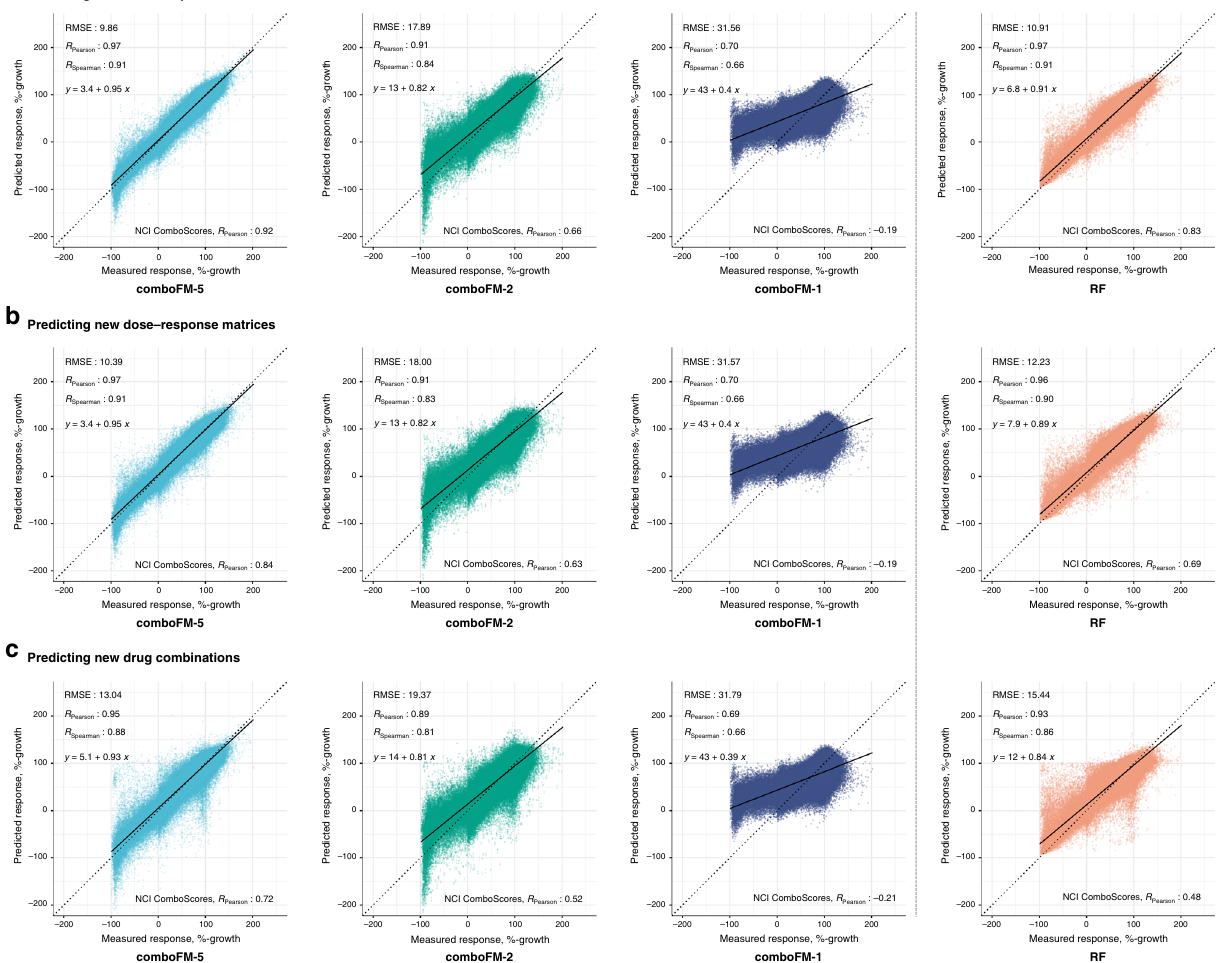
Fig. 2 Predictive performance of 5th (comboFM-5), 2nd (comboFM-1) and 1st order comboFM (comboFM-1), and random forest (RF) as scatter plots between the measured and predicted dose – response matrices. The responses were measured by percentage growth in the three prediction scenarios: a new dose – response matrix entries, b new dose – response matrices, and c new drug combinations. Root mean squared error (RMSE), Pearson correlation (RPearson) and Spearman correlation (RSpearman) for the drug combination response prediction are reported as averages over 10 outer CV folds. The Pearson correlation of the NCI ComboScores is reported as an average over all computed NCI ComboScores, computed based on the predicted dose – response matrices. Trend line and its equation are shown for each scatter a distribution of an in-house drug combination dataset, consisting of 60 drug combinations tested against 16 KRAS-mutants pancreatic ductal adenocarcinoma cell lines. Since the combina- tions in the reference set were not randomly-selected, the background synergy distribution shows a slight positive bias; however, since the assay was the same as the one used for the experimental validation of comboFM predictions ( “ Methods ” ), it is expected to provide a valid reference distribution for statistical evaluations. All the drug combinations predicted by comboFM were validated as synergistic, when considering positive Bliss score as evidence for a degree of synergy ( p < 10 − 4 , binomial test against the background distribution). Importantly, 9 out of 16 combinations had a Bliss synergy score higher than 90% of the background distribution ( p < 10 − 5 , binomial test). In addition to Bliss synergy score, we also computed the synergy scores using three other popular synergy models: Loewe, highest single agent (HSA) and zero-interaction potency (ZIP) scores (Supplementary Figs. 9 and 10). These results demonstrate the robustness of the comboFM predictions across various experimental setups and synergy scoring models.